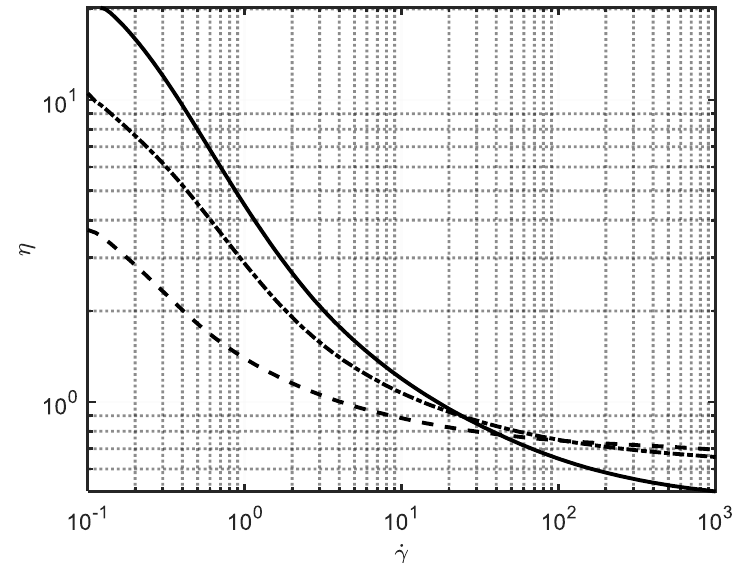
Figure 1. Rheological behavior of the product at different ingredients percentages.